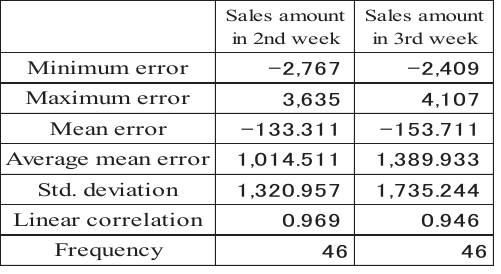
Fig. 5. Forecasting results using verification data.